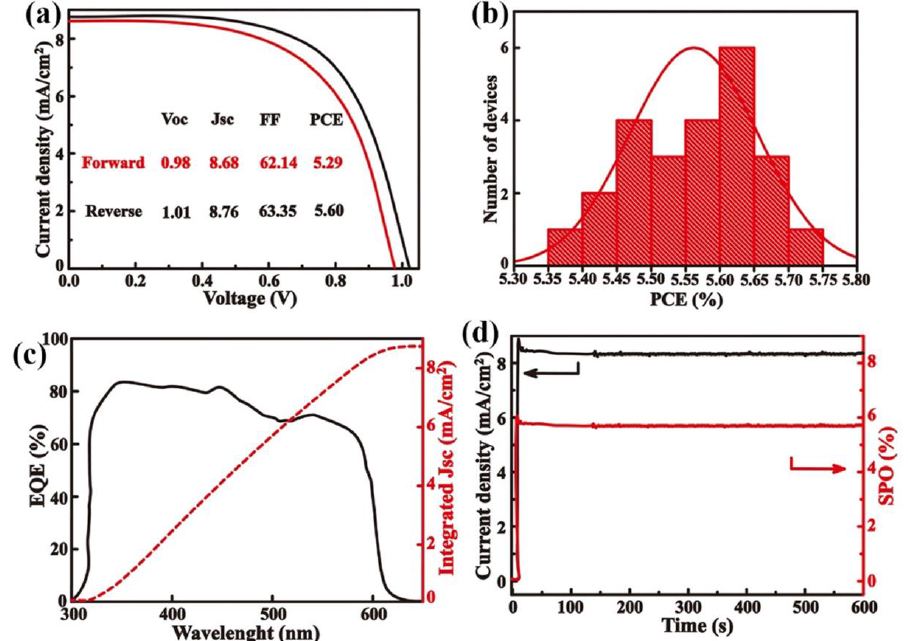
Figure 5. ( a ) The current-voltage ( J-V) curves of perovskite solar cells measured in different scan directions. ( b ) Statistical power conversion efficiencies (PCEs) of 24 independent cells. ( c ) The corresponding external quantum efficiency (EQE) spectrum together with the integrated J sc of the champion CsPbIBr 2 PSC. ( d ) Steady-state maximum PCE outputs.